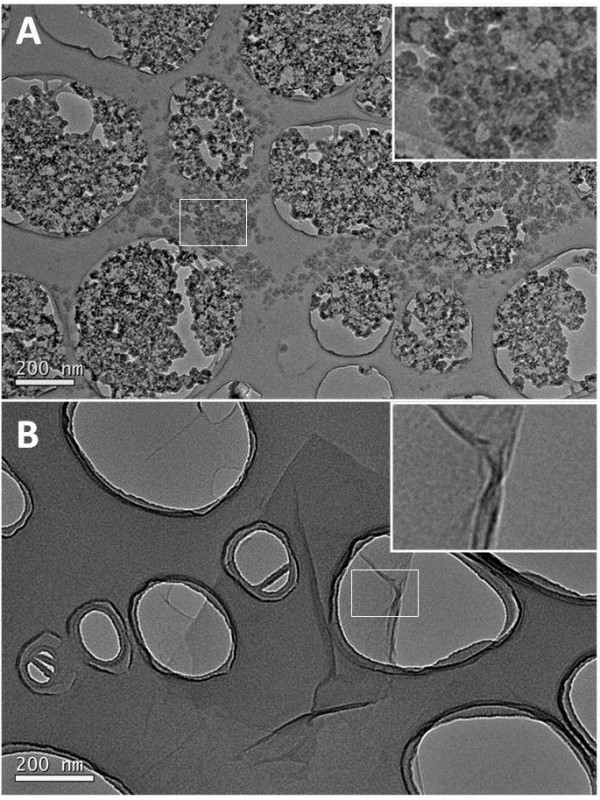
TEM micrographs of GO and CXYG stock suspensions. TEM images of GO stock suspensions (A) demonstrated aggregates/agglomerates of GO nanoplatelets with lateral dimensions in the lower nanometer range. TEM images of CXYG stock suspensions (B) demonstrated comparatively larger, thin sheets. The inserts in the upper right corner of the images show the boxed-in areas at higher magnification. The large round holes visible in both micrographs represent defects in the carbon coating of the copper grid. The scale bar represented in the lower left corner of the images corresponds to 200 nm.